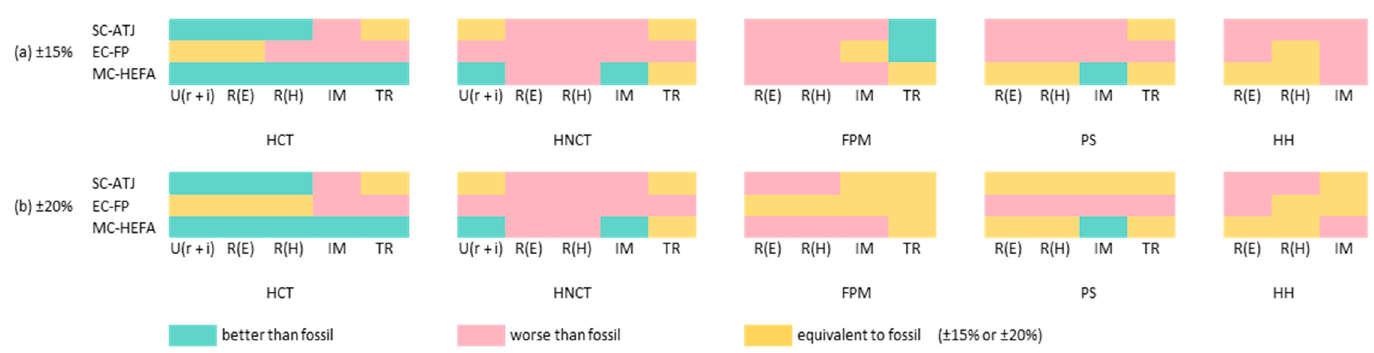
Figure 3. Color matrices illustrating the qualitative comparison between aviation biofuels and fossil jet fuel with regard to each impact category (HCT: human carcinogenic toxicity, HNCT: human non-carcinogenic toxicity, FPM: fine particular matter, PS: Photochemical smog, HH: human health; U (r + i): USEtox 2 (r + i), R (E): ReCiPe (E), R (H): ReCiPe (H), IM: IMPACT2002+, TR: TRACI), considering tolerance ranges of ( a ) ±15% and ( b ) ±20%.